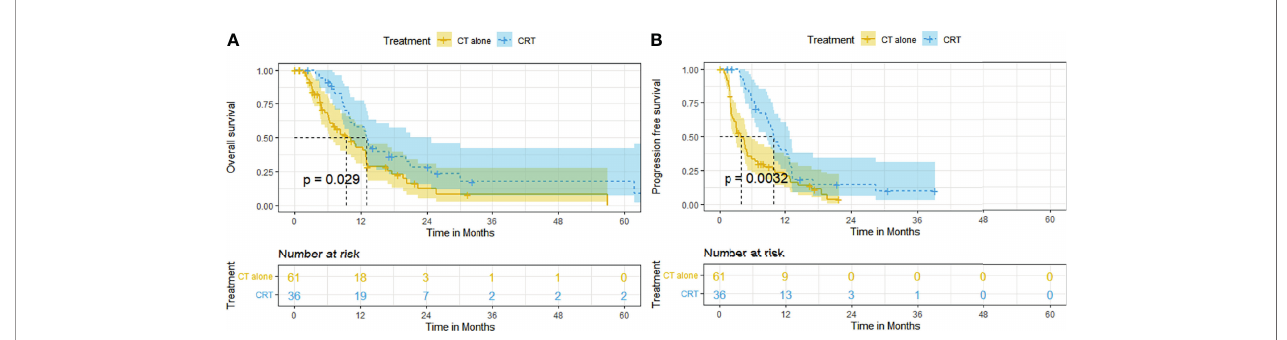
FIGURE 4 | Kaplan – Meier curves of survival in patients with metastatic ESCC treated with CRT and CT: (A) overall survival; (B)